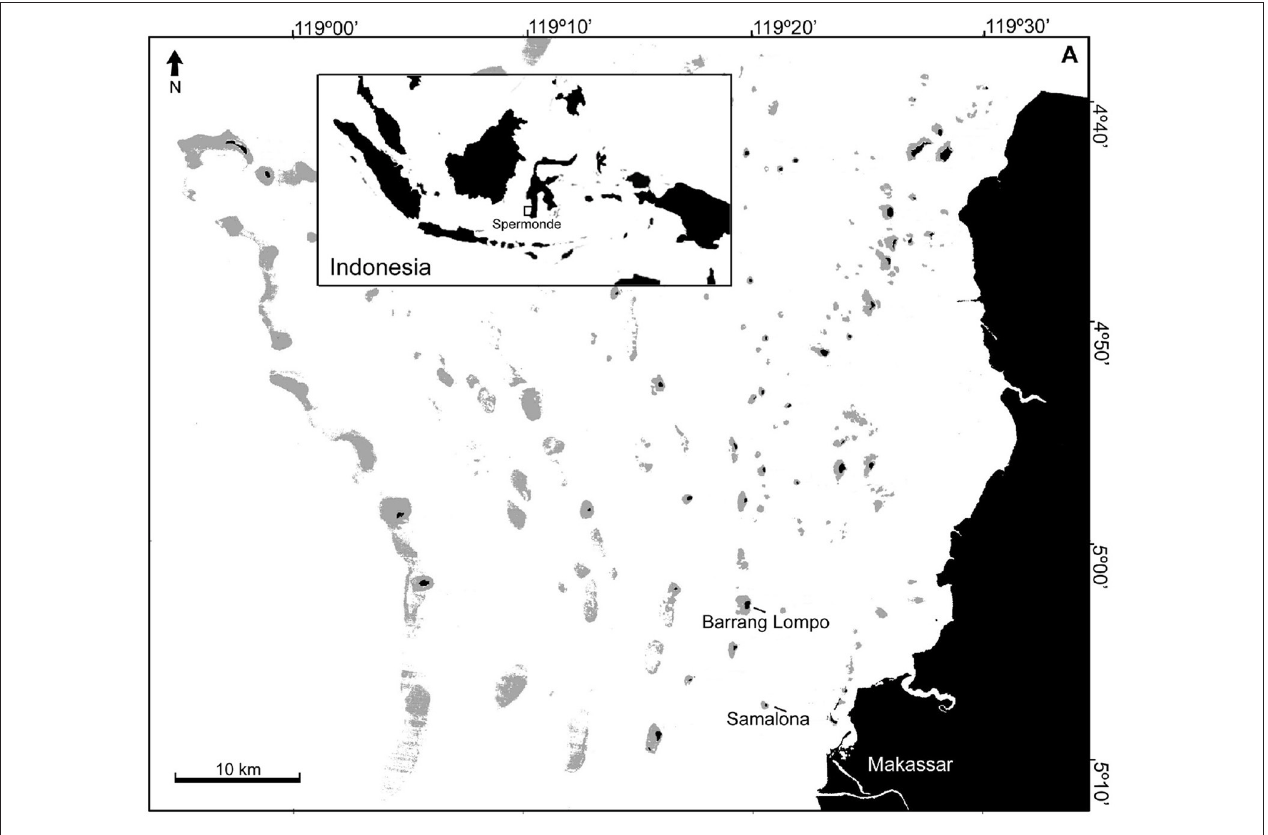
FIGURE 1 | Study sites: Barrang Lompo and Samalona are located in the midshelf of the Spermonde Archipelago.